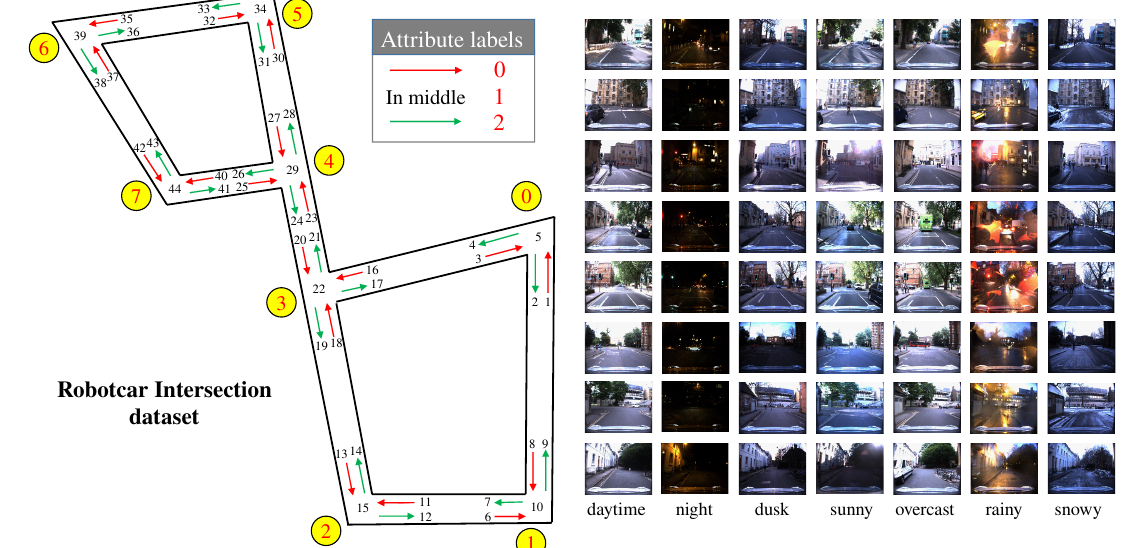
Figure 6. Examples of intersection labels. We label each image with an intersection ID, an attribute ID and a global ID. The ID arrangement is determined by the designated driving route in clockwise order. Image samples in different weathers are from [6].